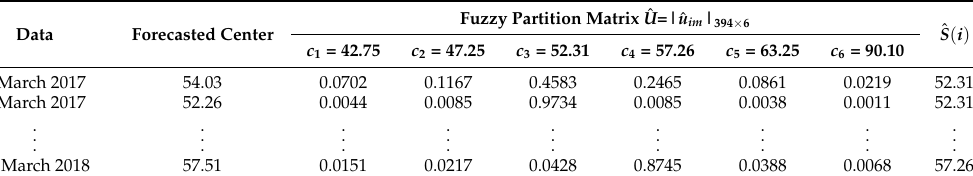
Table 5. Forecasted states.